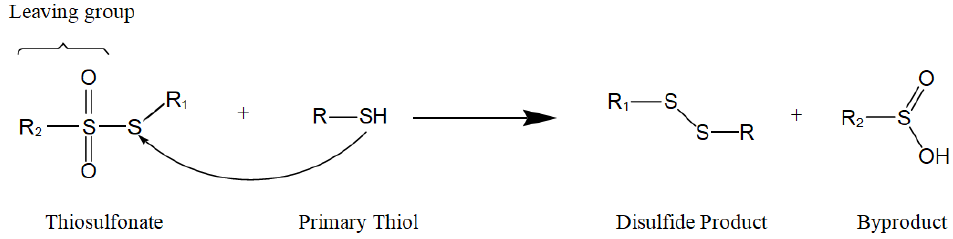
Figure 1. General mechanism of the reaction between a thiosulfonate and a